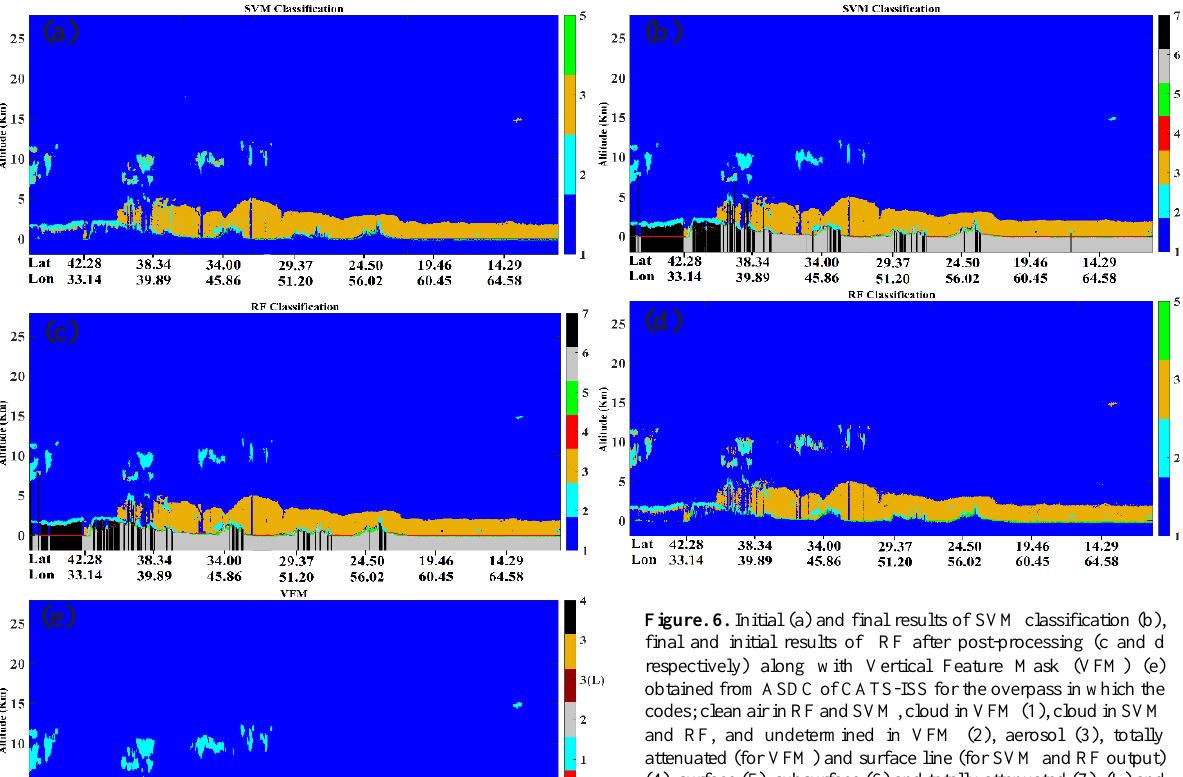
Figure. 6. Initial (a) and final results of SVM classification (b), final and initial results of RF after post-processing (c and d respectively) along with Vertical Feature Mask (VFM) (e) obtained from ASDC of CATS-ISS for the overpass in which the codes; clean air in RF and SVM, cloud in VFM (1), cloud in SVM and RF, and undetermined in VFM (2), aerosol (3), totally attenuated (for VFM) and surface line (for SVM and RF output) (4), surface (5), subsurface (6) and totally attenuated (7). (L) and N/A in VFM represents low/no confidence and not applicable